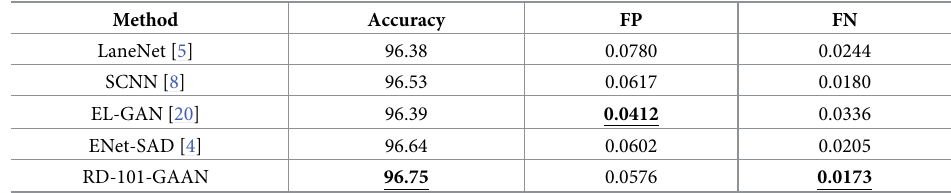
Table 8. Evaluation of GAAN in TuSimple dataset.